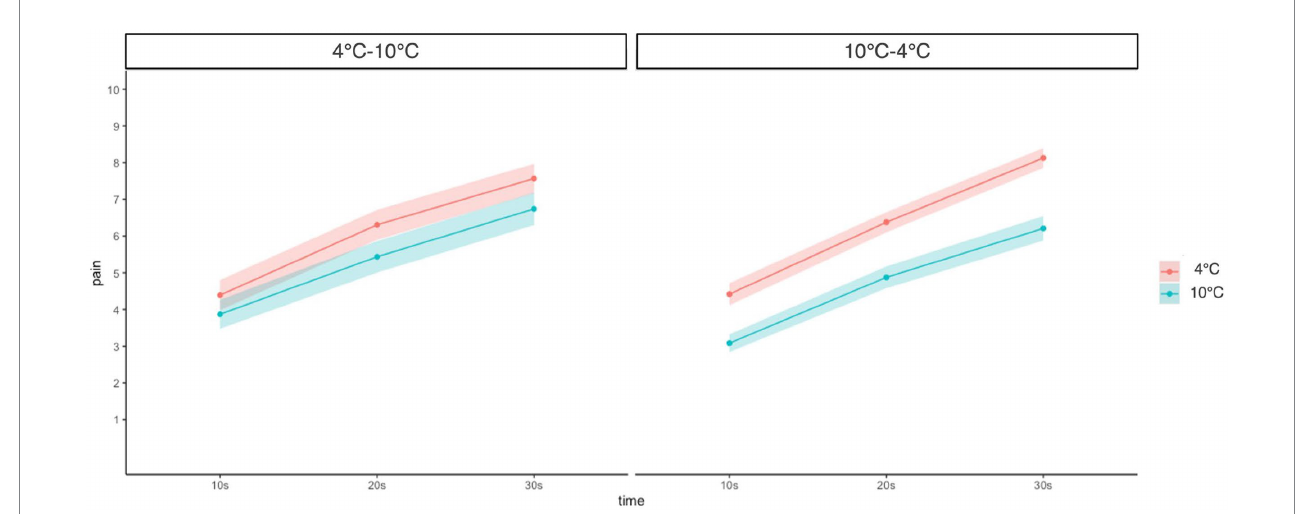
FIGURE 2 Change of pain intensity at different time points and temperatures compared between groups. Error bars represent standard errors of the